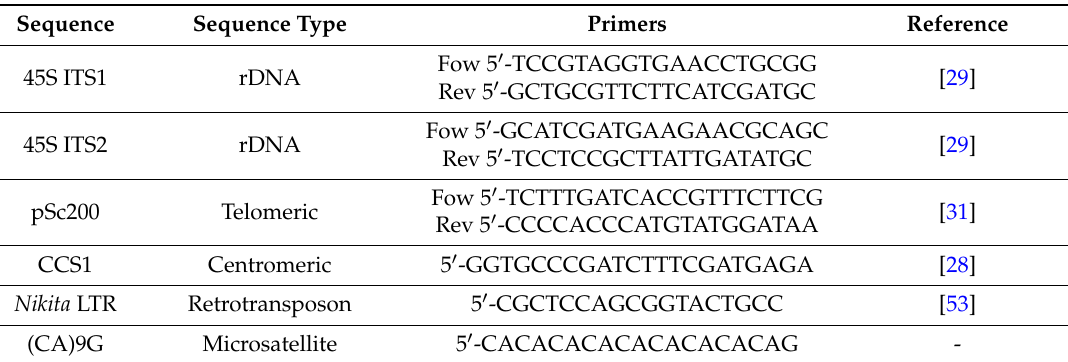
Table 4. Primers used in PCR